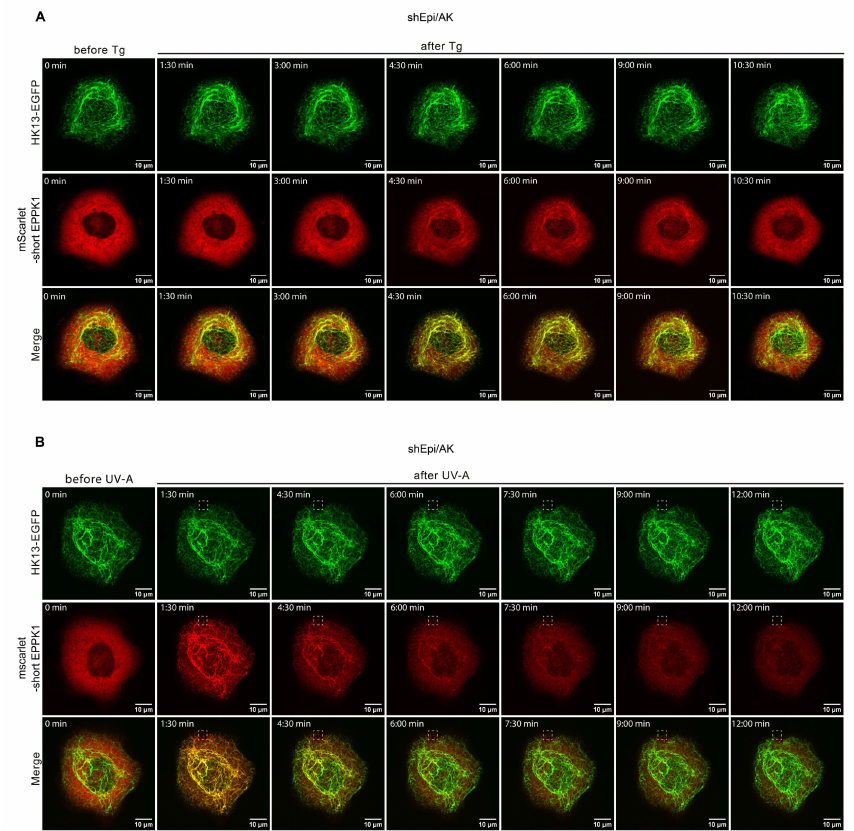
Figure 2. EPPK1 re-localization to keratin filaments after Tg treatment and irradiation with a UV-A laser is reversible. ( A ) Live-cell imaging of shEpi/AK cells treated with 100 nM Tg. Upon treatment , short EPPK1 (red) re-localized to keratin filaments (green) within 4 min and 30 s and returned to a mostly diffuse state within 10 min 30 s after treatment. Images correspond to Video S1. ( B ) Live-cell imaging of shEpi/AK cells partially irradiated with a UV-A pulse of 16 J/cm 2 in the area indicated by a dashed square. The applied UV-A dosage corresponds to physiological UV-A irradiation levels (up to 60 J/cm 2 ) [25]. Images were taken every 90 s, and a z-stack was acquired for every time point. UV-A irradiation was applied once after three images were acquired. Upon UV-A treatment of shEpi/AK cells, short EPPK1 (red) re-localized to keratin filaments (green) within 1 min and 30 s and returned to a mostly diffuse state within 12 min after irradiation. Images correspond to Video S2. Scale bar: 10 µ